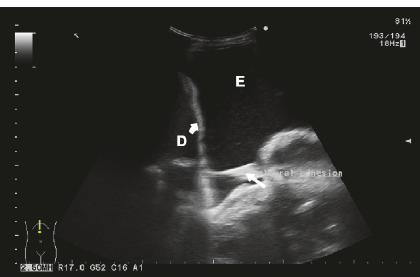
Figure 4: Pleural adhesions. Pleural adhesions (right white arrow) with sharp contours, hyperechoic, connecting the diaphragmatic pleura and parenchyma of the collapsed lung. D = diaphragm (left bold white arrow); E = pleural